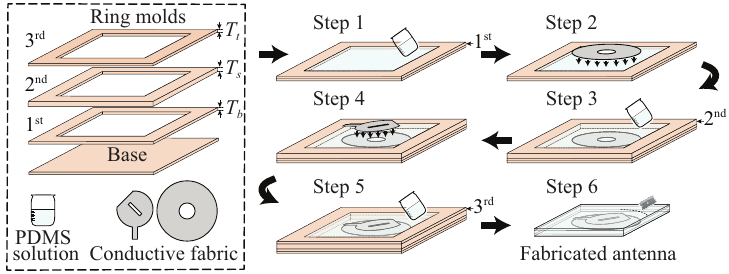
Figure 12. Schematic representation of the antenna fabrication process. Below, the details of the manufacturing process are